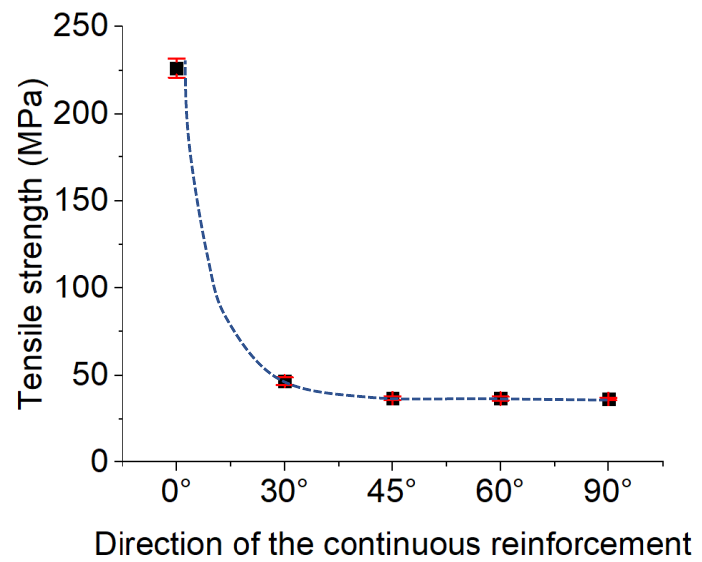
Figure 17. Effect of the direction of the continuous reinforcement on the tensile strength.